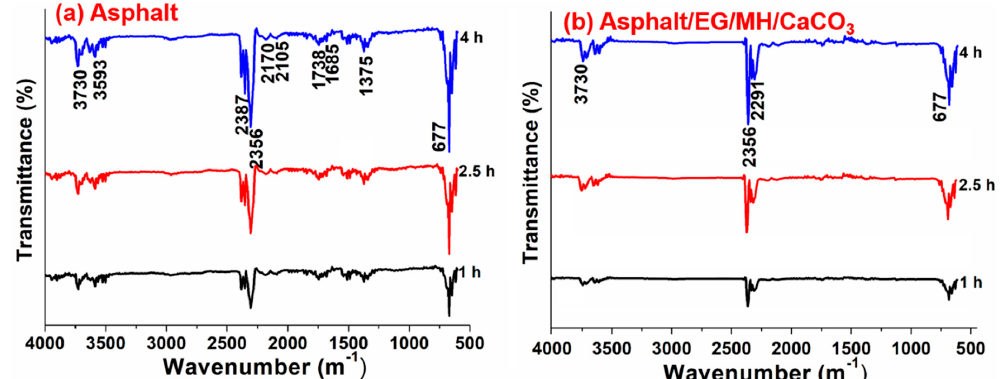
Figure 6. FTIR test results of volatiles released from ( a ) asphalt and ( b ) asphalt / EG / MH / CaCO 3 during the isothermal-oxidative aging.